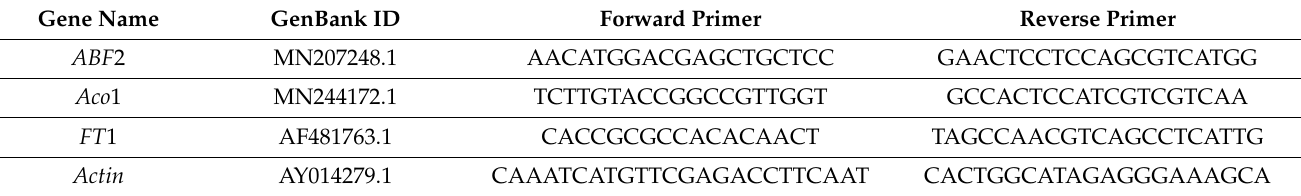
Table 1. Genes, sequence origins, and designed primers and probes used in the